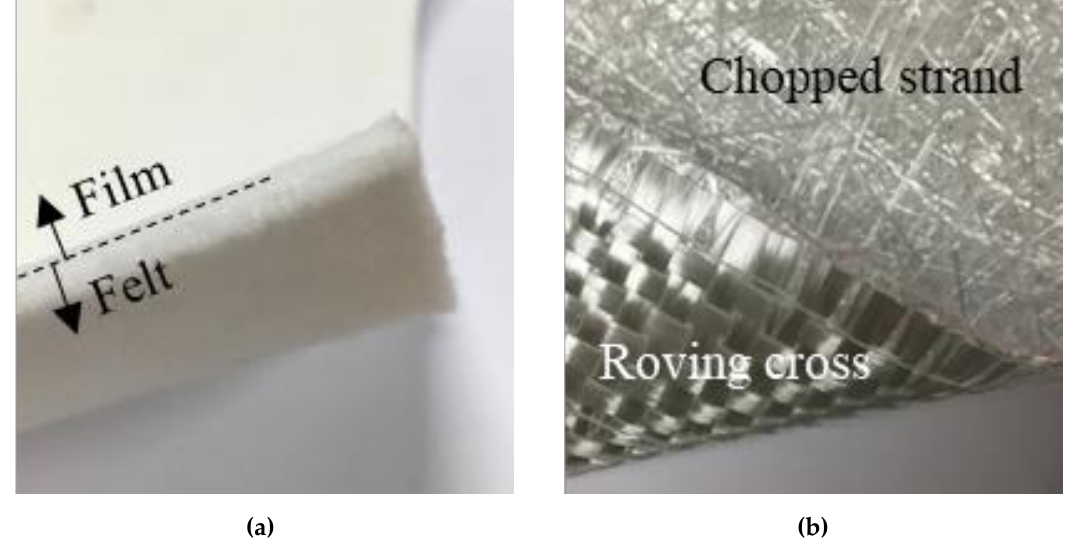
Figure 3. Appearance of materials for CIPP liner. ( a ) Polyester nonwoven felt with CF and ( b ) Roving cross glass fiber and chopped strand mat.